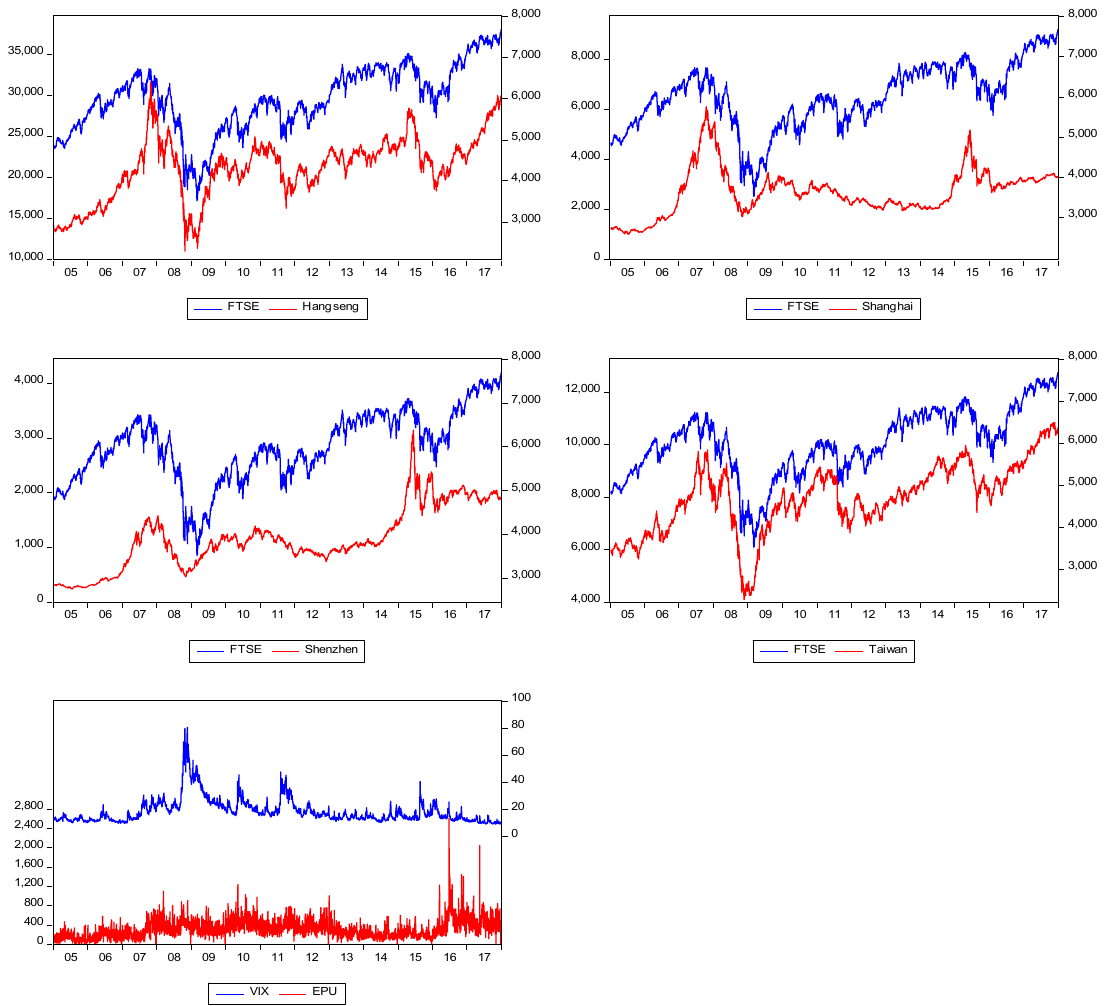
Figure A1. Indices Behavior from 2005 to 2017.